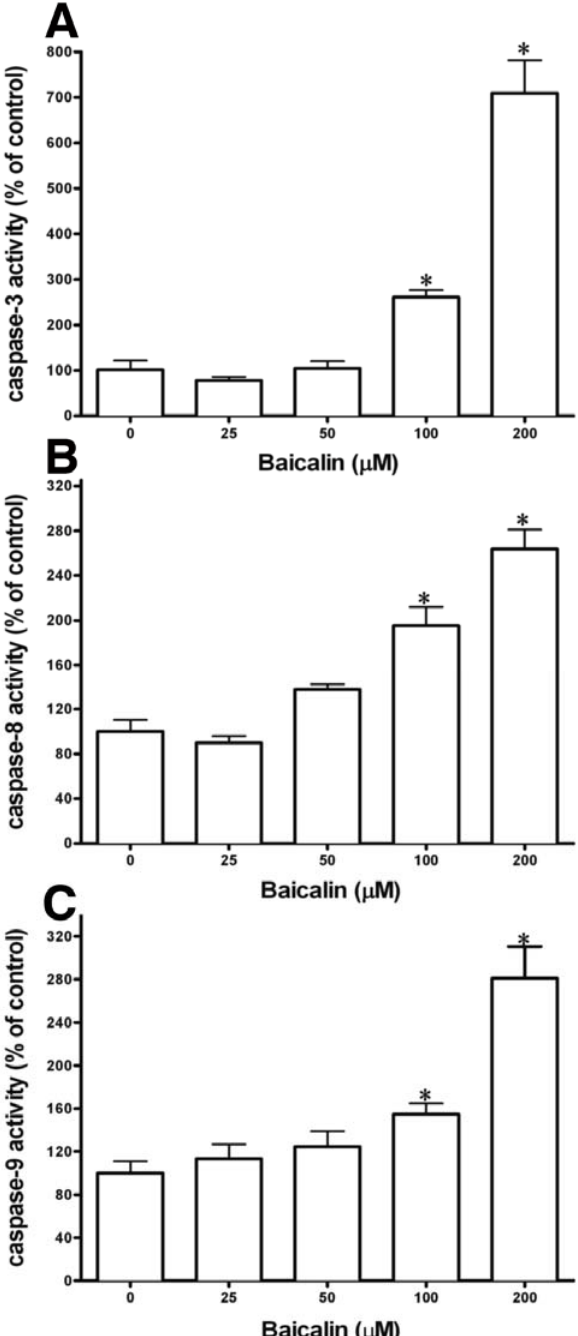
Figure 4. Baicalin’s effects on caspase-3, -8 and -9 activities. SW620 cells were treated with 200 µM baicalin for 48 h. Caspase activities of SW620 cells were determined with caspase activity detection kits. ( A ) Caspase-3, ( B ) caspase-8, and ( C ) caspase-9. Three experiments were performed in triplicate. * p < 0.05, compared to the control group. Reduce size of A–C in